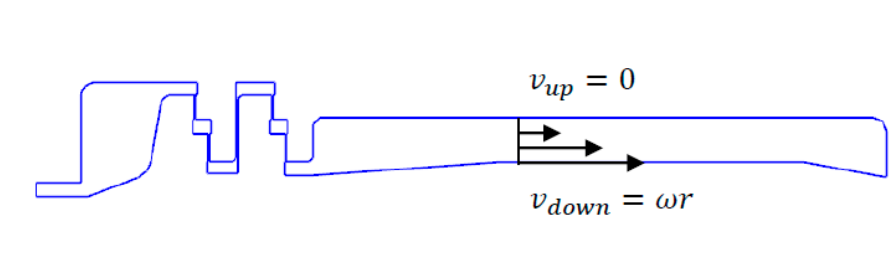
Figure 13. The velocity gradient in clearance.